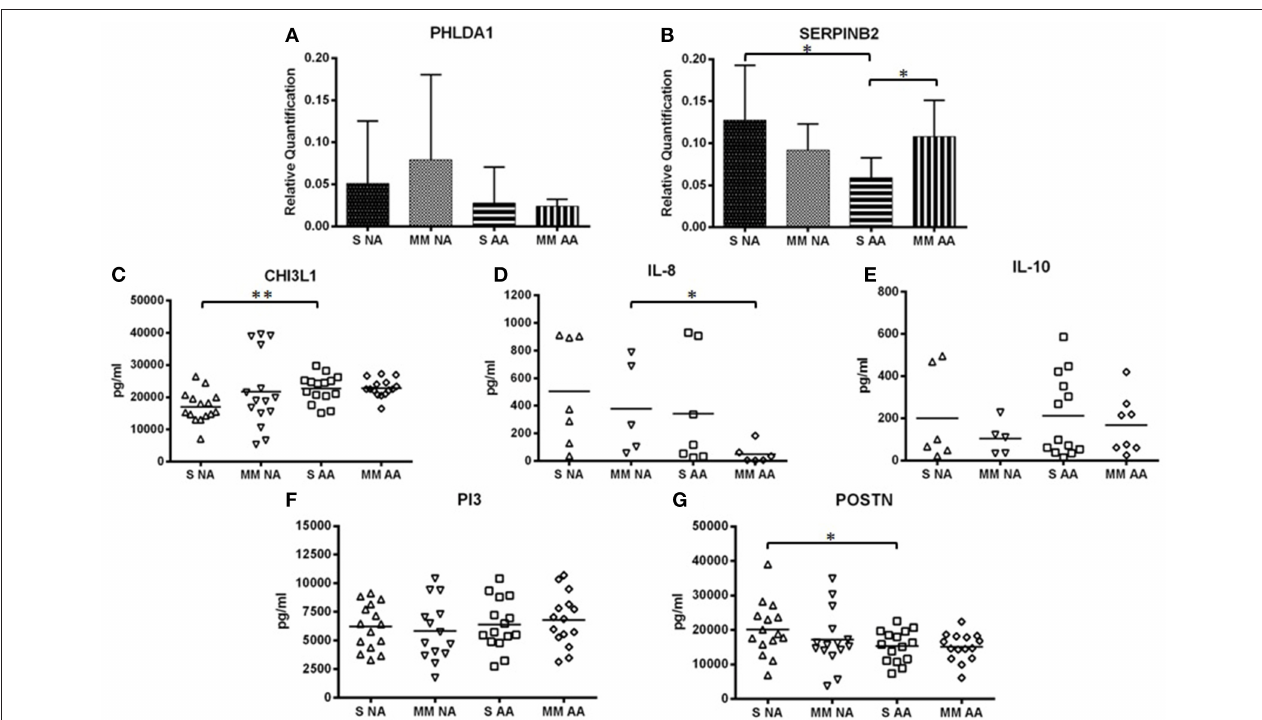
FIGURE 2 | Mean levels of protein expression by asthma severity subgroup. (A) Mean levels of PHLDA1. (B) Mean levels of SERPINB2. (C) Mean levels of CHI3L1. (D) Mean levels of IL-8. (E) Mean levels of IL-10. (F) Mean levels of PI3. (G) Mean levels of POSTN. *Statistically significant comparison ( p < 0.05) between the indicated groups. **Statistically significant comparison ( p < 0.005) between the indicated groups. Protein levels of PHLDA1 were measured by Western blot in 3 severe NA and 2 moderate-mild NA patients, 3 patients with severe AA, and 3 with moderate-mild AA. Protein levels of SERPINB2 were measured by Western blot in 6 severe NA and AA subjects and in 5 moderate-mild NA and AA patients. Densitometric analysis was done in individual blots (see “Materials and Methods”) using the β -actin protein for normalization. CHI3L1, IL-8, IL-10, PI3, and POSTN were quantified by ELISA in all patients studied. The levels and relative expression of the proteins studied were compared among groups by unpaired t -test, using the Graph-Pad InStat 3 program. The error bars indicate the standard deviation. S, group of subjects with severe asthma; MM, group of subjects with moderate-mild